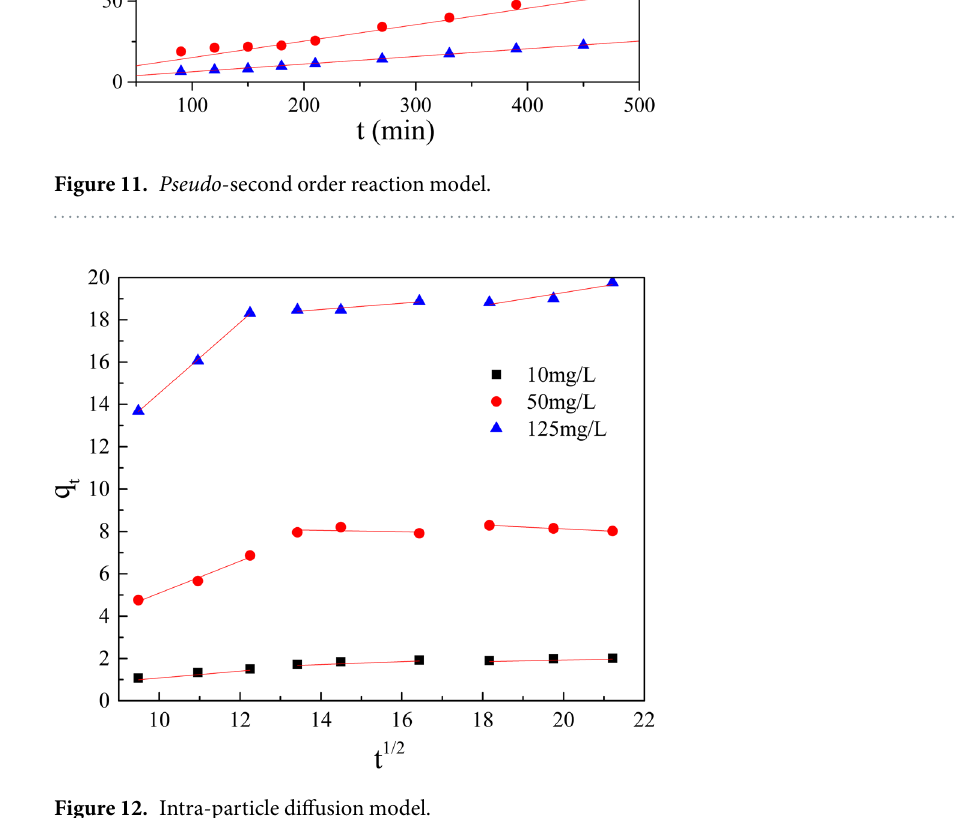
Figure 12. Intra-particle diffusion model.